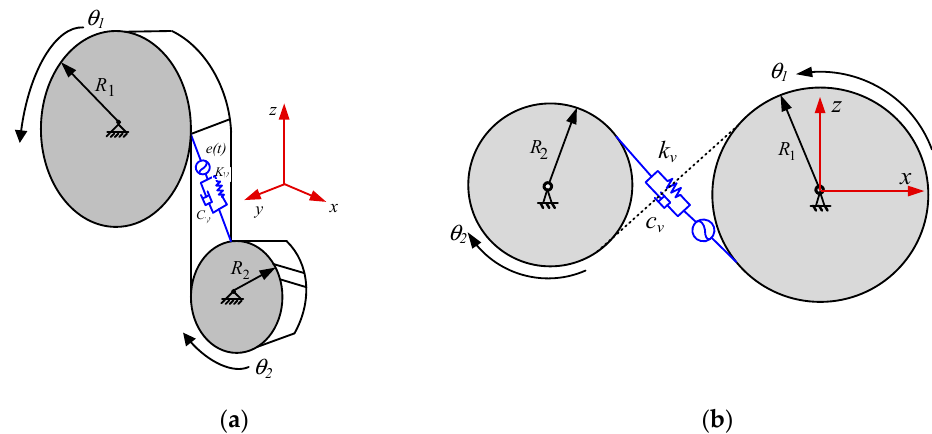
Figure 7. Torsional vibration model of helical gear pair: ( a ) stress diagram; ( b ) transmission